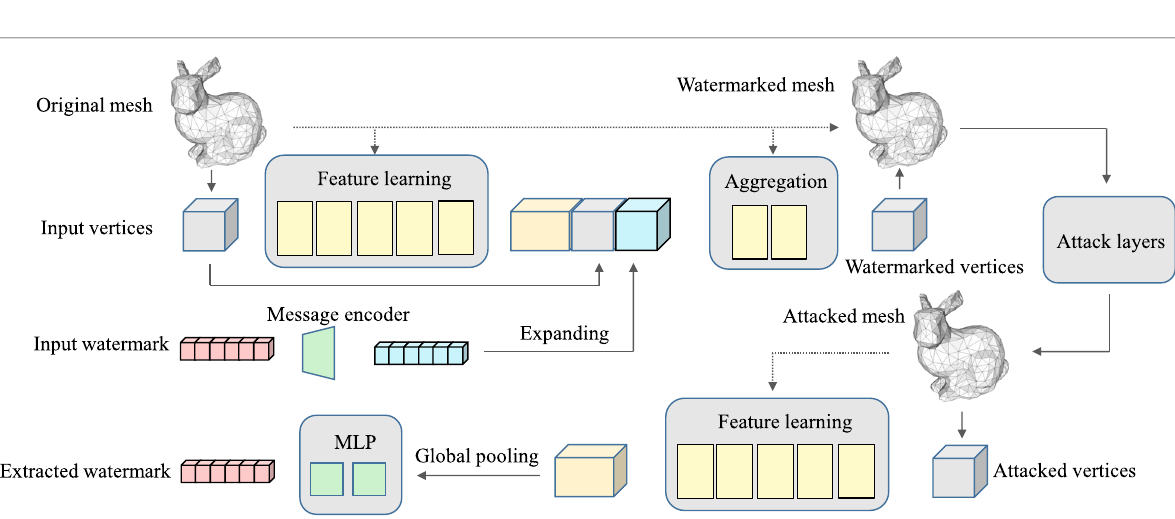
Fig. 3 Proposed watermark network architecture. The dashed line represents the reference information that guides the convolution operation and mesh